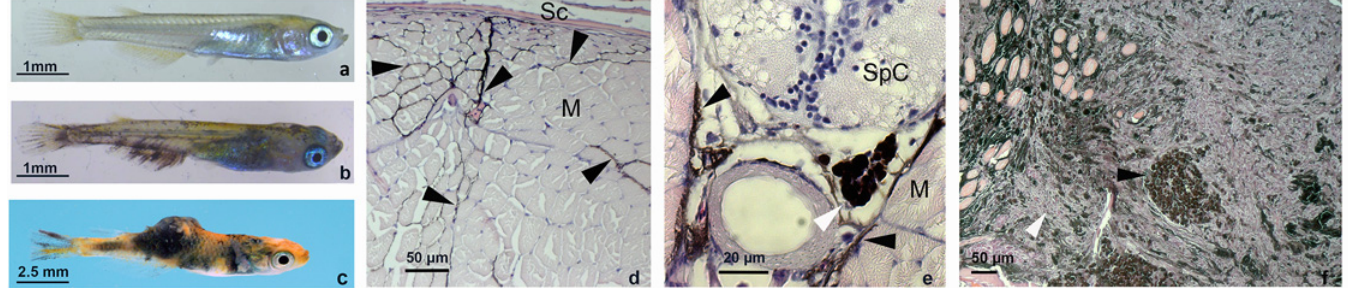
Fig 1. Transgenic medaka model for melanoma in juvenile fish (a) Control sibling and (b) fish with the mitf : xmrk transgene showing onset of malignant melanoma spreading over the fins and invading the body musculature at 3 – 4 weeks age (c) fish at 8 weeks of age with invasive and nodular melanoma. (d, e) Transverse sections through the posterior region of 4 weeks old mitf : xmrk transgenic medaka. (d) Melanoma invasion deep into the body trunk musculature. (e) Nest of melanoma cells (white arrowhead) close to the spinal cord. M muscle bundles, Sc scale, SpC spinal cord, black arrowheads point to stretches of invading melanoma cells, scale bars represent 50 μ m in (d) and 20 μ m in (e). (f) a nodular melanoma in an adult mitf : xmrk medaka. The white arrowhead points to an area with lowly differentiated melanoma cells and a black arrowhead indicates a nest of heavily pigmented melanoma